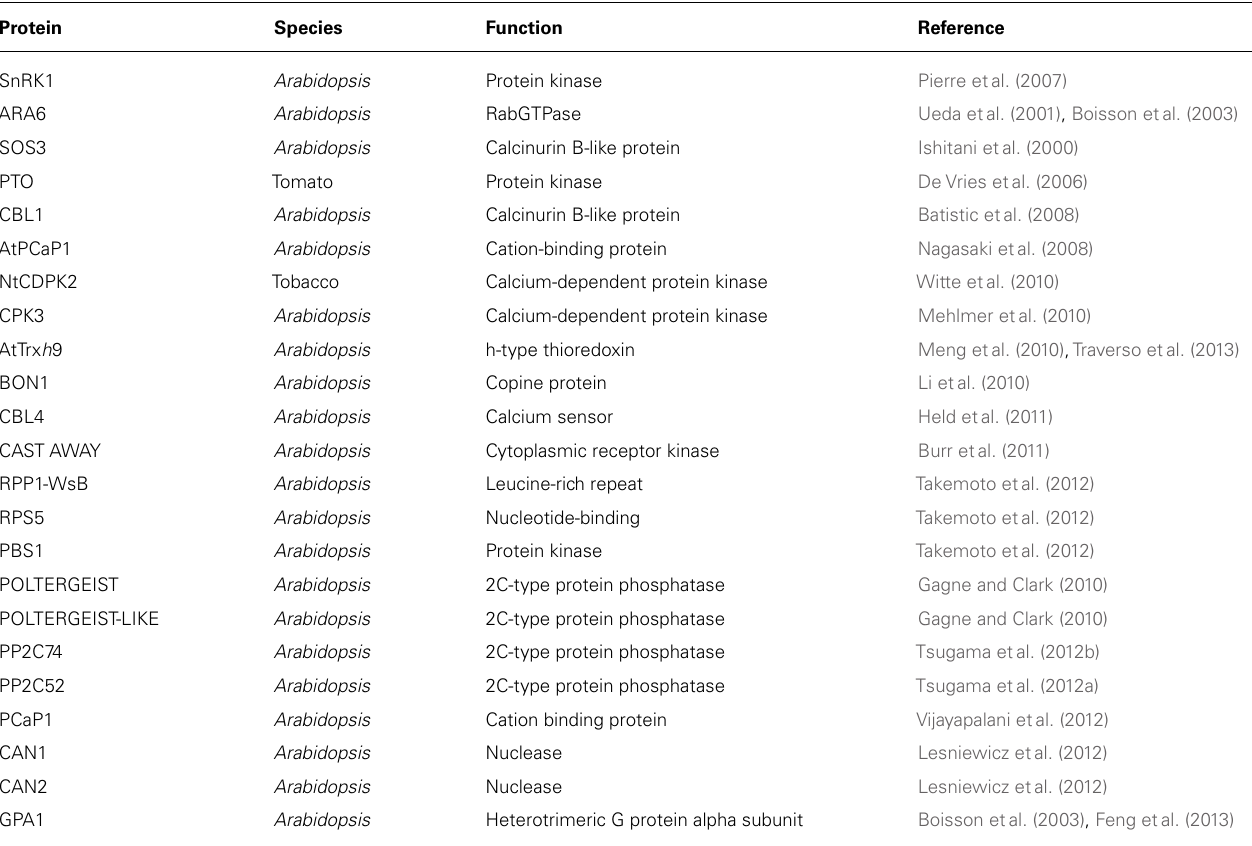
Table 2 | Myristoylated